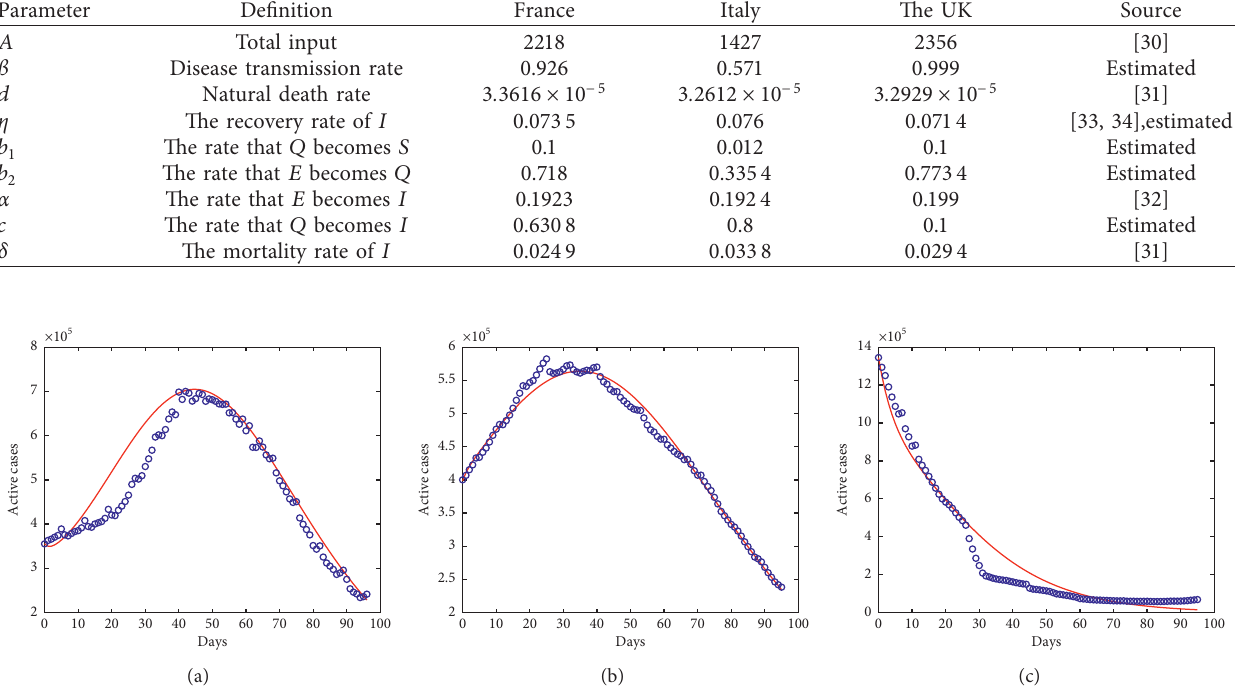
Figure 4: The fitting results of system (1). (a) France. (b) Italy. (c) The